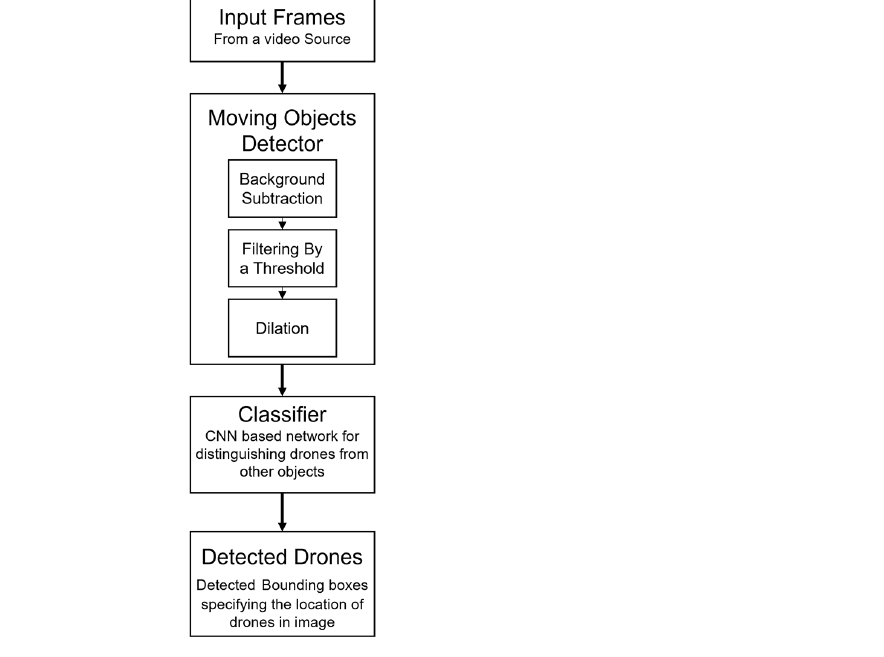
Figure 6 . Proposed UAV detection algorithm used in electro-optical method [43] . Table 5. Summary of reviewed electro-optical sensor-based techniques for UAV characterization.